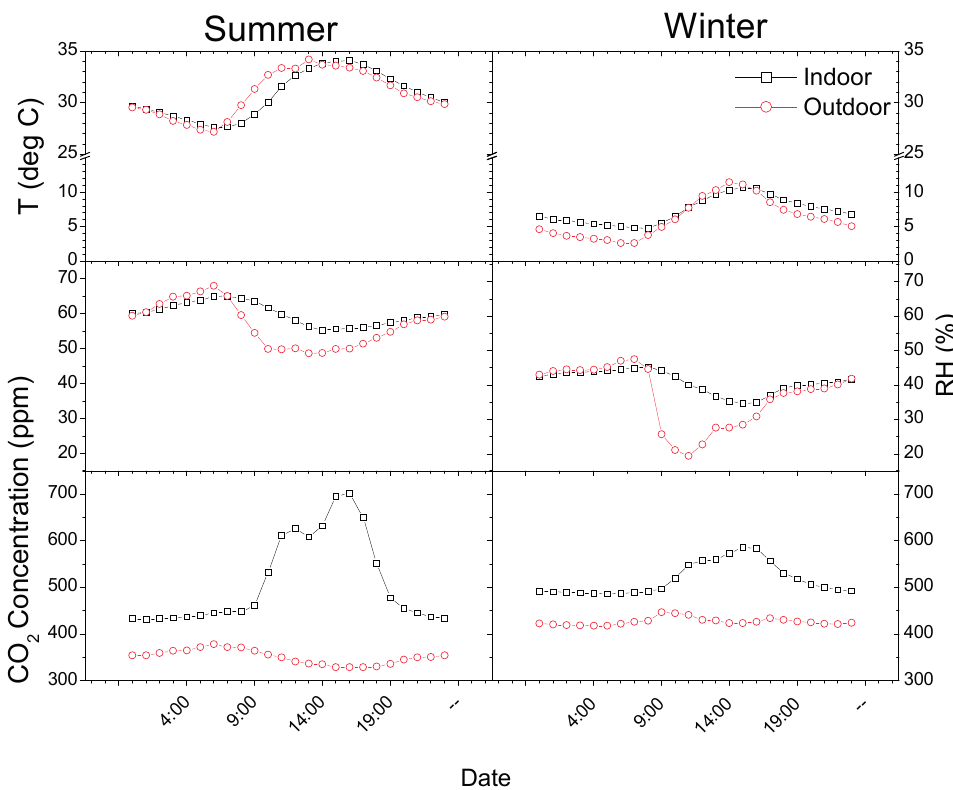
Figure 2. Fourteen-day averaged diurnal fluctuations in air temperature, relative humidity and concentrations of carbon dioxide inside and outside Pit No. 1 Display Hall of Emperor Qin’s Terra-cotta Museum in the summer and winter sampling campaigns in 2013,